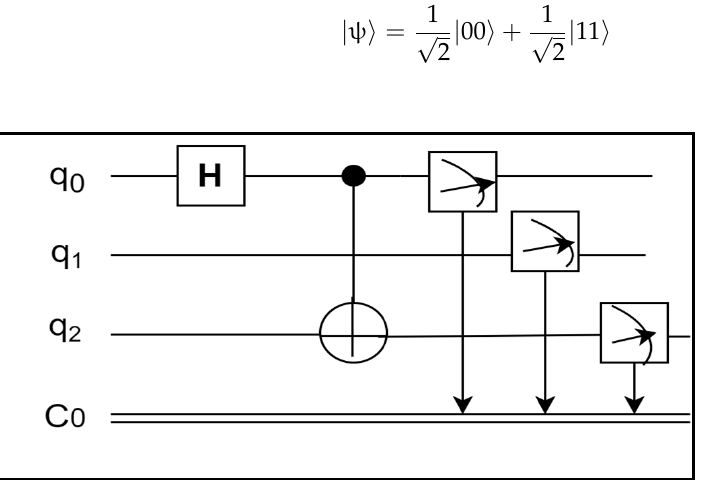
Figure 2. The quantum circuit for the three-qubit entanglement is depicted in the illustrations. Here, the controlled-NOT gate is applied, the Hadamard gate is applied to the qubits and the measurement is applied to every qubit. q 0, q 1 and q 2 are the quantum registers and c 0 classical register.